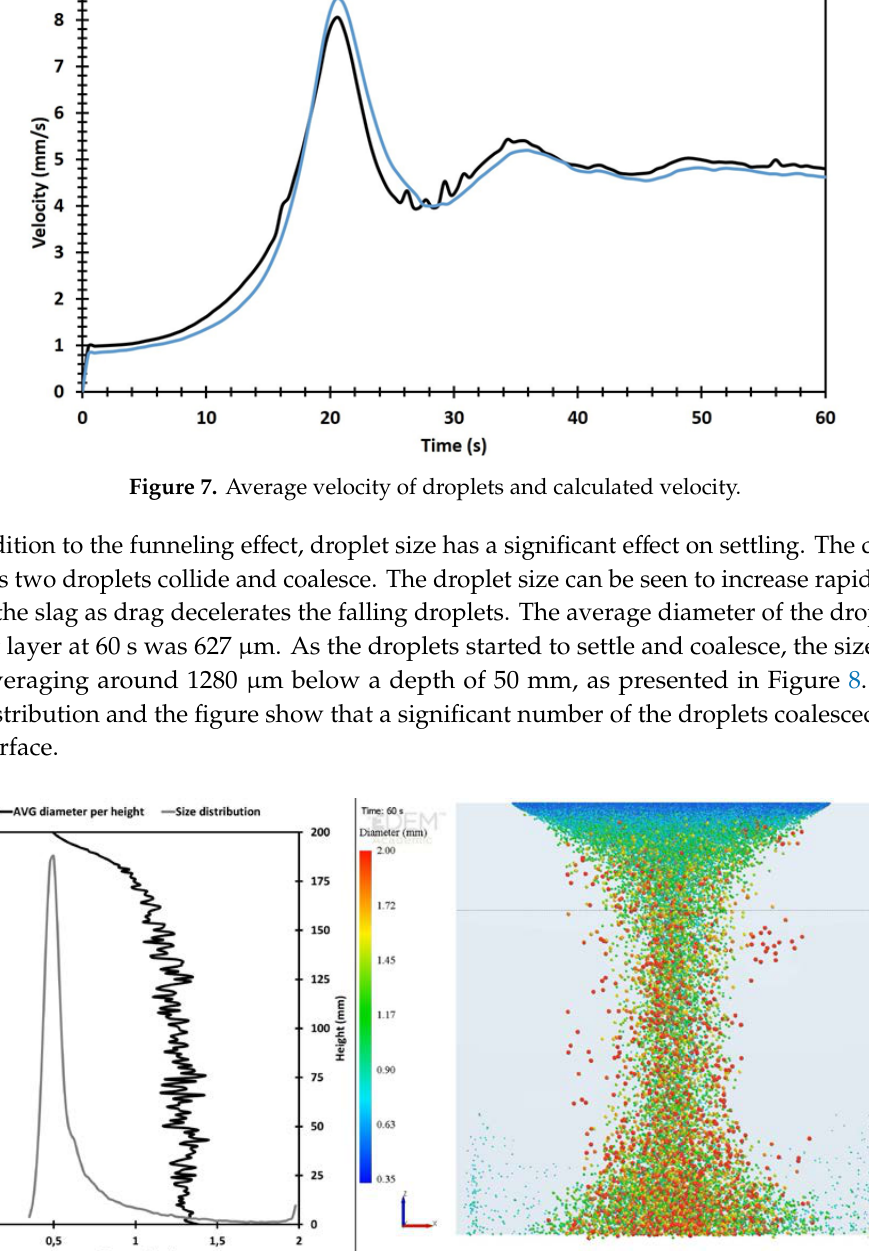
Figure 8. Droplet sizes in the slag layer at 60 s. The 50 mm settling distance is marked with a line.